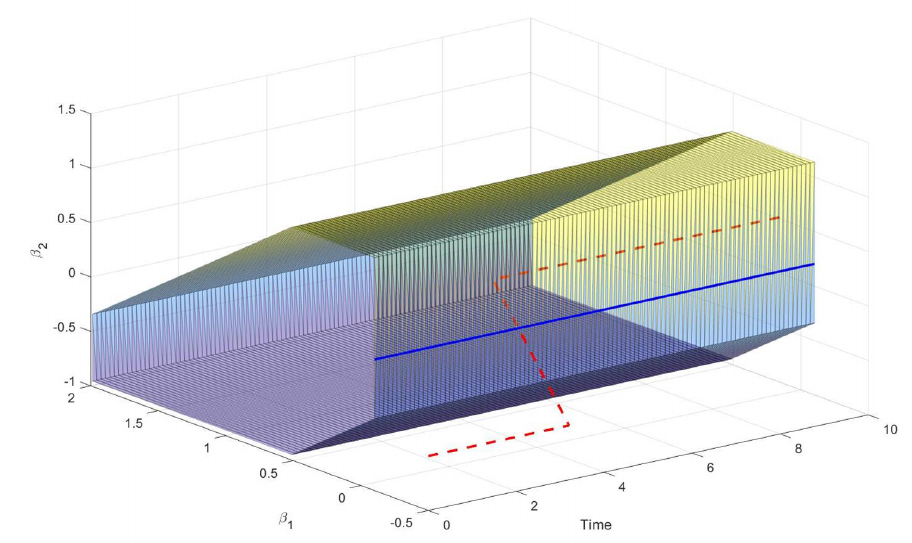
Figure 1. Axes: β 1 , β 3 , t . β 2 can be found using the equality in (25).